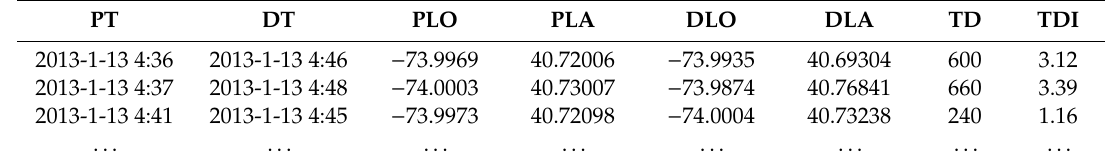
Figure 1. Working of GPS. Table 1. Samples of taxi GPS data.